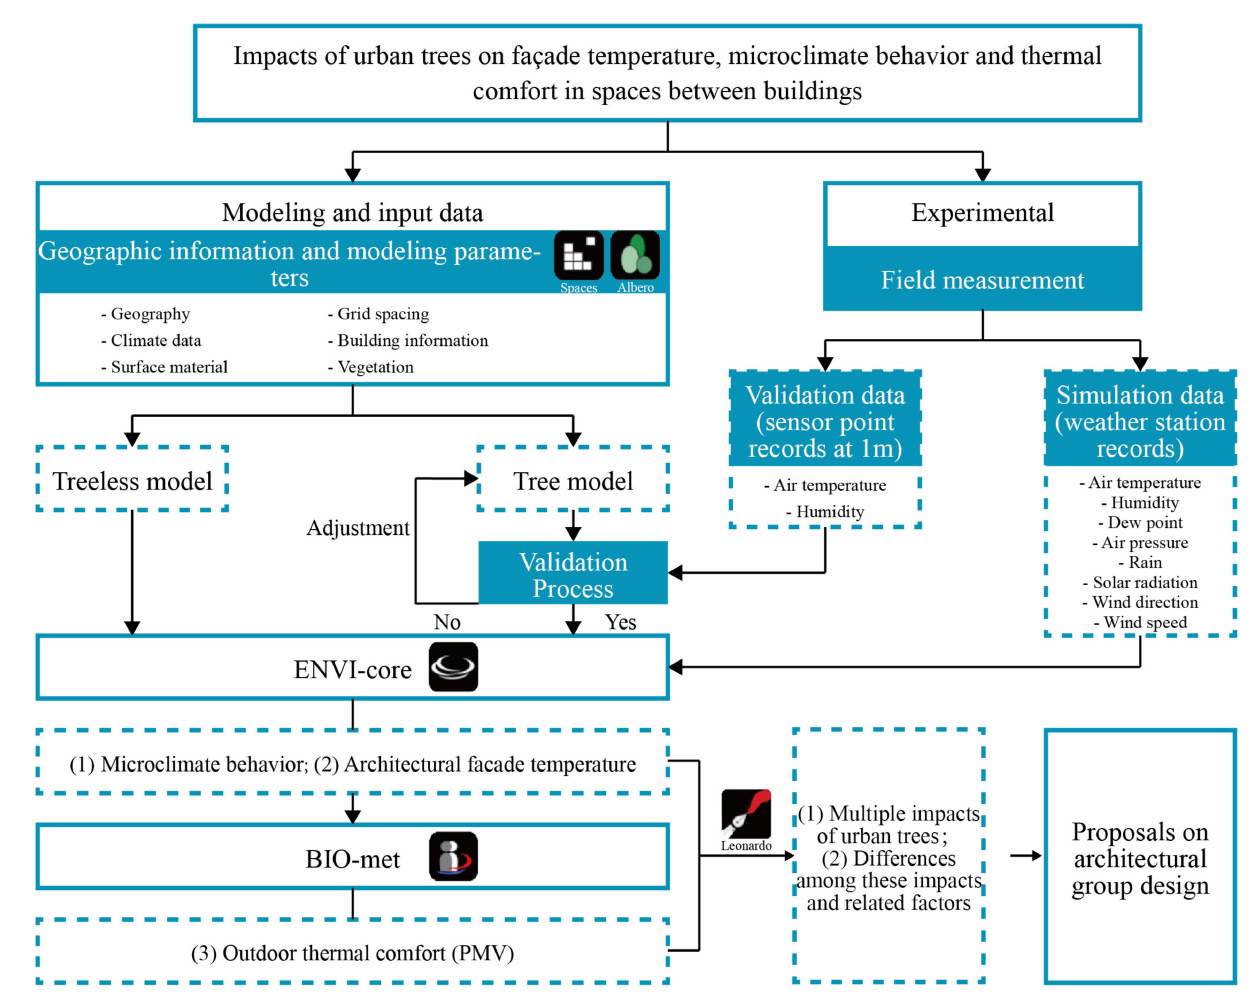
Figure 1. Framework of research method used in this